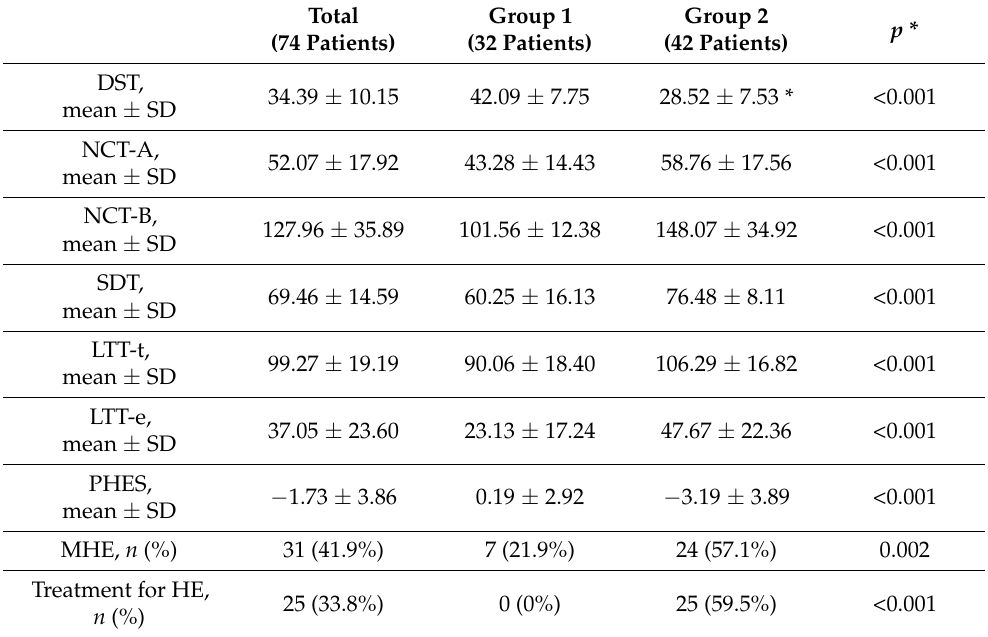
Table 2. Comparison between PHES results of early-stages versus advanced-stages of